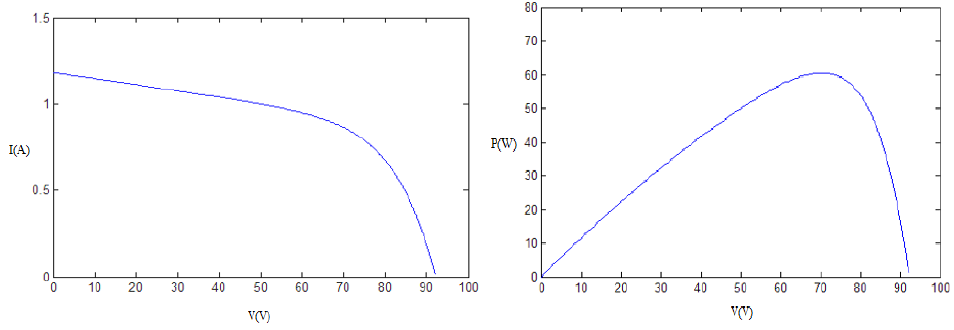
Figure 19. I–V and P–V curves of the KANEKA 60.